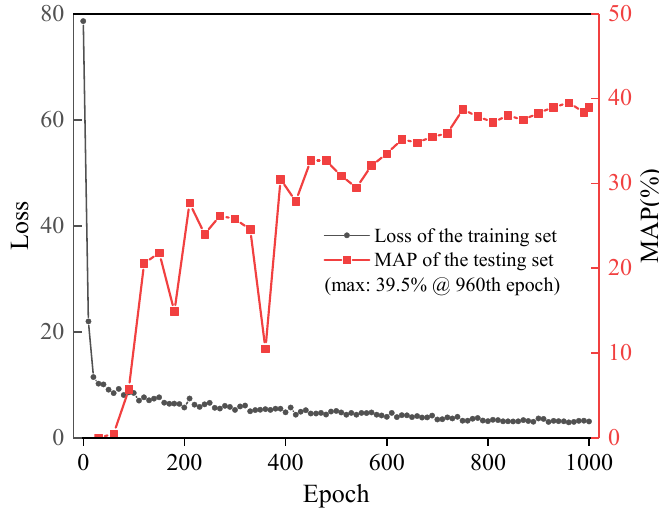
Figure 9. MAP and Loss-epoch curves of the YOLOv5 model.